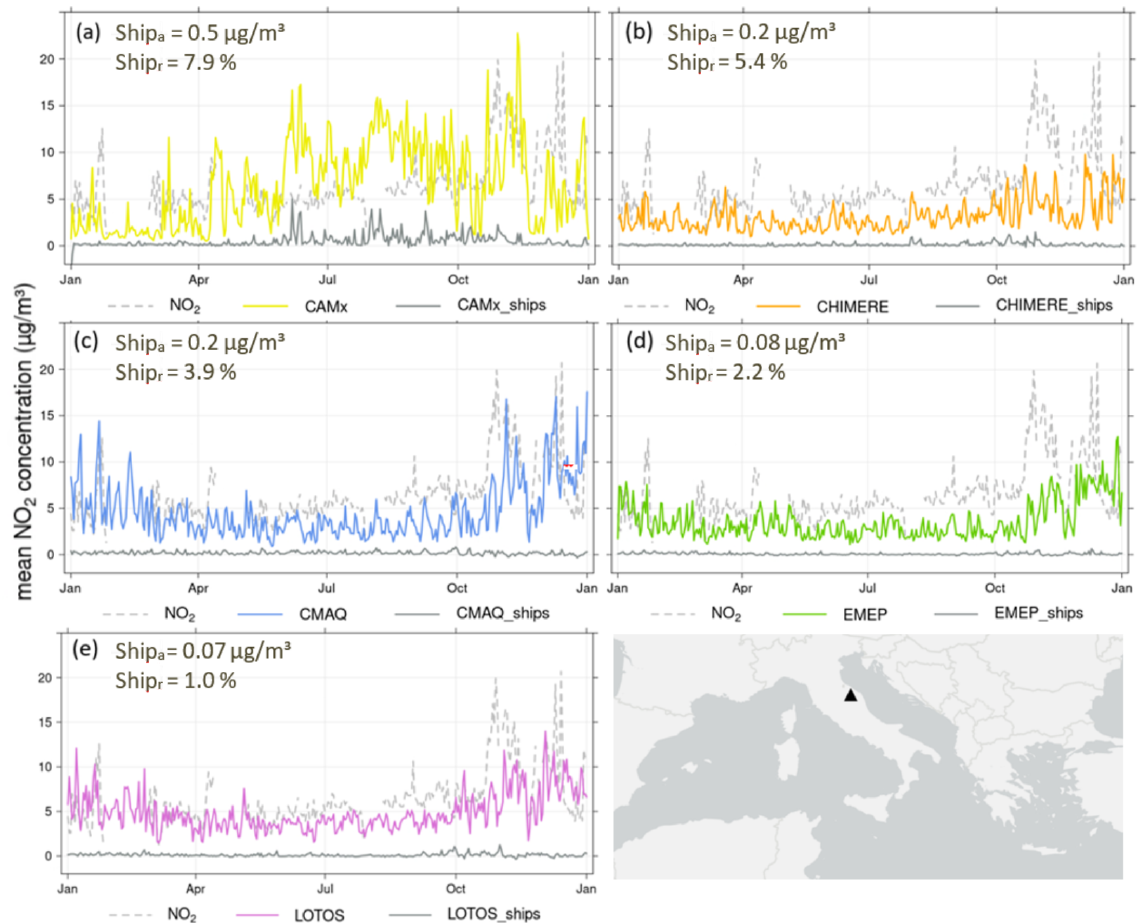
Figure C2. Time series with daily mean NO 2 concentration in 2015 at station it1773a in Italy. The black triangle on the map (bottom right) displays the location of the station. (a) CAMx; (b) CHIMERE; (c) CMAQ; (d) EMEP; (e) LOTOS-EUROS. Dashed gray line – measured data; colored lines – modeled data; gray line – modeled potential ship impact. Correlation between modeled and measured data for hourly total emission data for 2015: CAMx = 0 . 03; CHIMERE = 0 . 03; CMAQ = 0 . 20; EMEP = − 0 . 09; LOTOS-EUROS = 0 . 14 Ship a : potential absolute ship impact; Ship r : potential relative ship impact of the respective